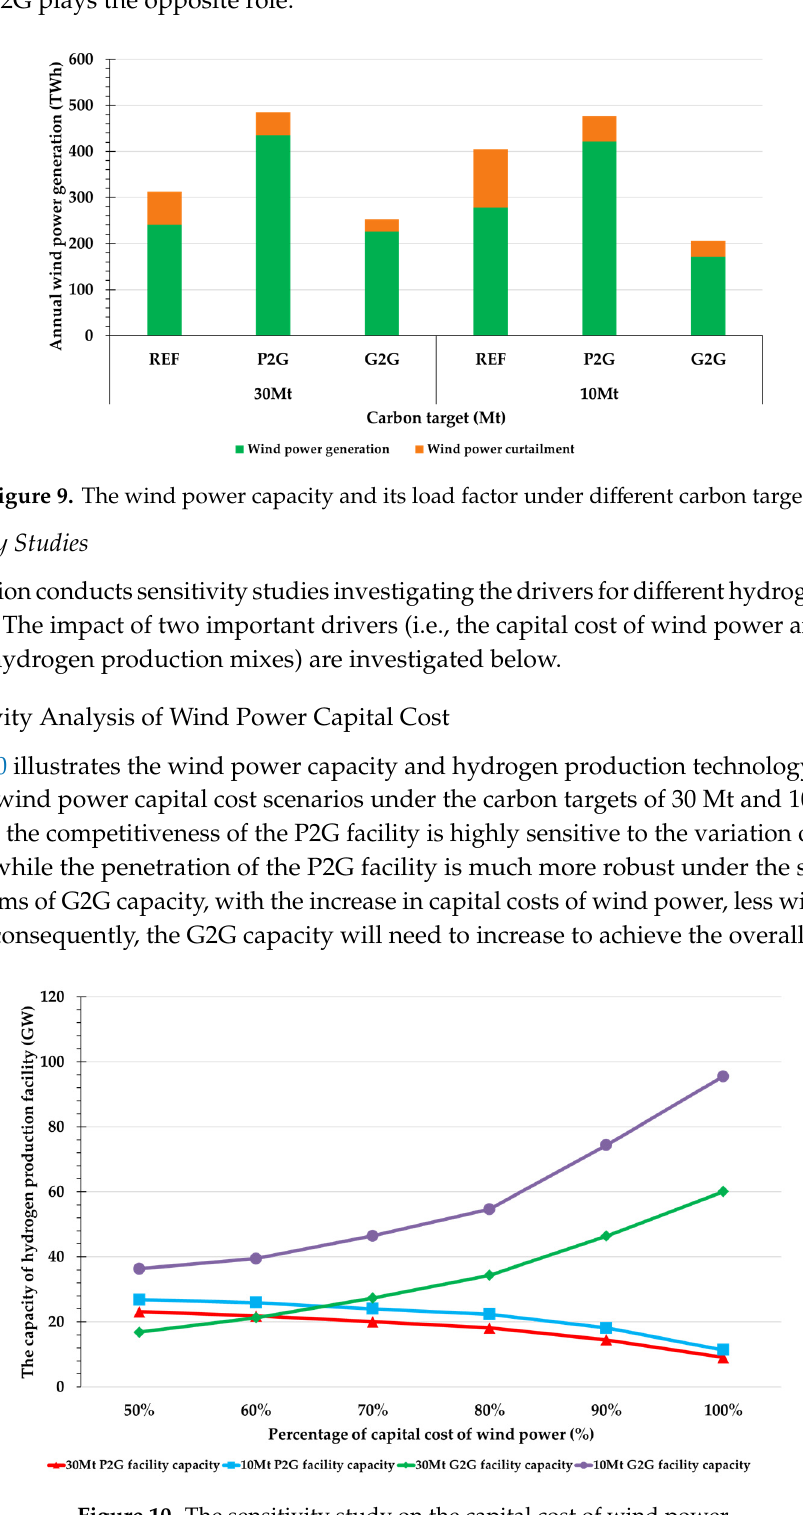
Figure 10. The sensitivity study on the capital cost of wind power.